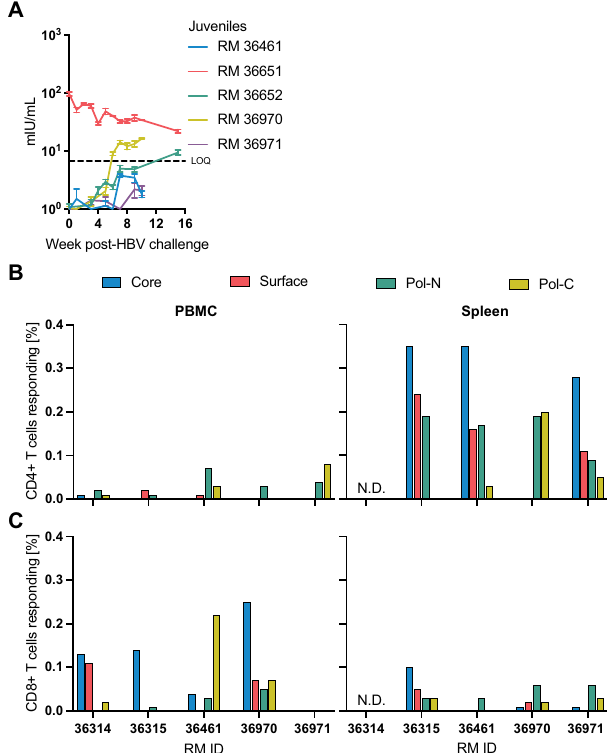
Fig. 2 HBV-speci fi c adaptive immune responses in RM. A Anti-HBs concentration in serum. B HBV-speci fi c CD4 + and CD8 + T cell responses in blood, mesenteric lymph nodes, and spleens of HBV-infected RM. Data are presented as mean values + / − SD. Source data are provided as a Source Data fi